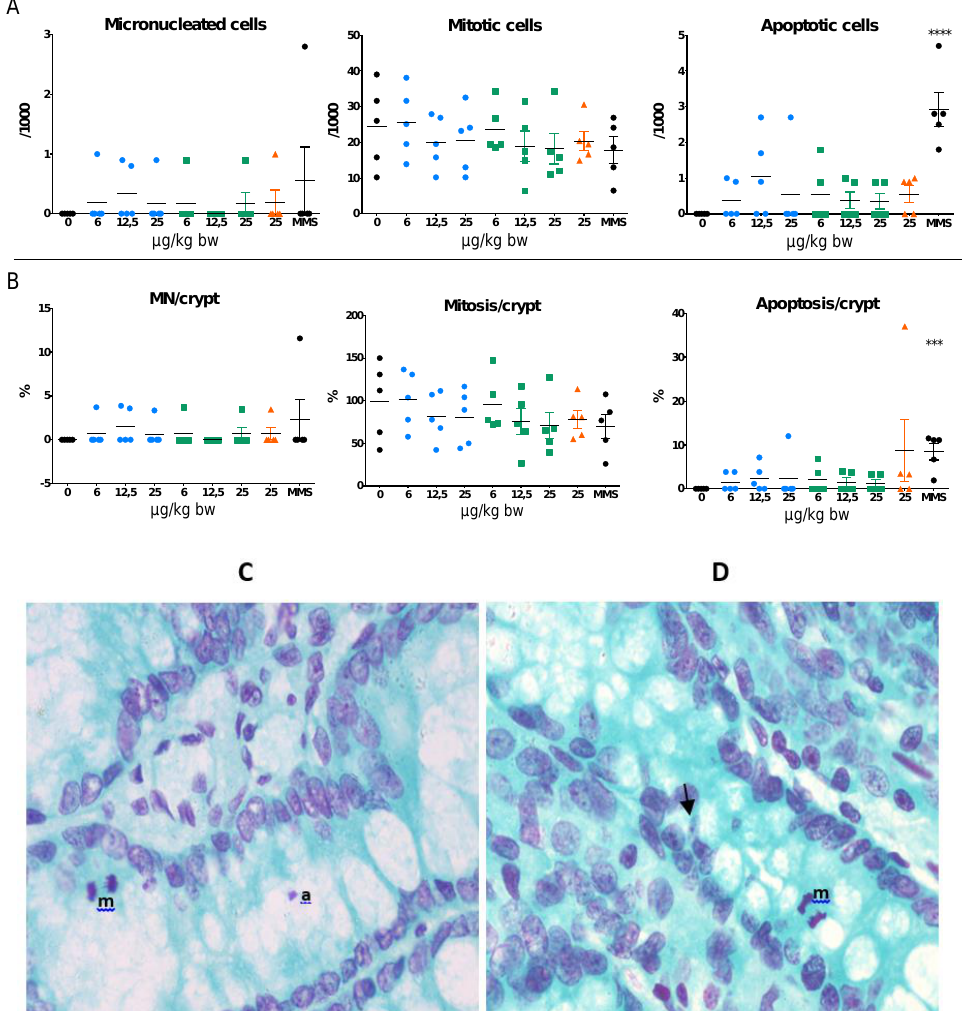
Figure 3. ( A ) MN, mitotic and apoptotic frequencies per 1000 cells in the colon of rats orally exposed to Al NMs and AlCl 3 or to the solvent control (0). ( B ) MN, mitosis and apoptosis percentages per crypt. Results correspond to individual values with mean ± SD (n = 5). Significant from control at *** p < 0.001, **** p < 0.0001 compared to the vehicle control. ( C , D ) Schiff’s reagent and fast green counterstained colon sections of rats treated with MMS ( C ) and Al 0 NMs at 12.5 mg/kg bw ( D ). Black arrow indicates micronuclei in cells. a: apoptosis, m: mitosis.